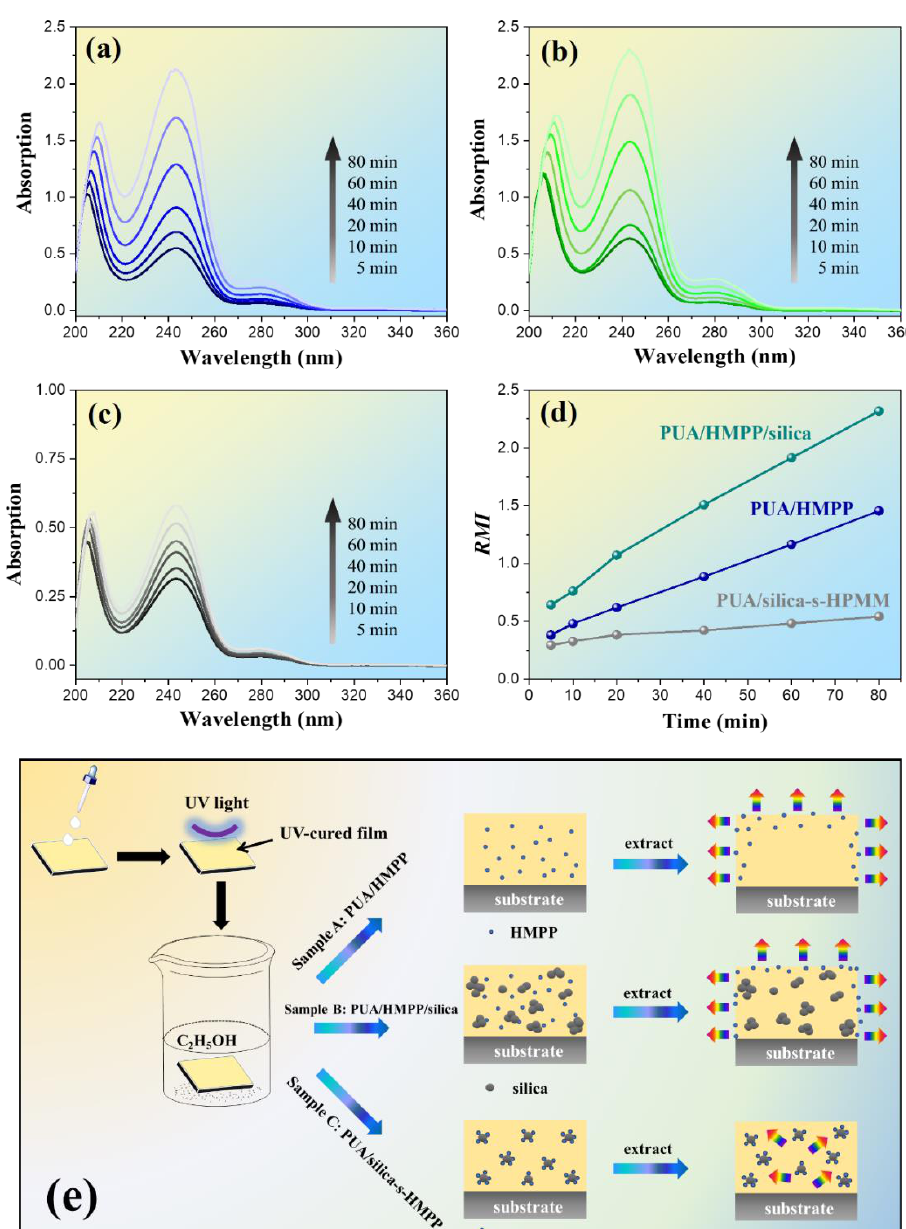
Figure 5. UV-vis absorption spectra of extractable content from UV-cured films ( a ) PUA/HMPP, ( b ) PUA/HMPP/silica, ( c ) PUA/silica-s-HMPP, ( d ) relative migration index (RMI) vs. immersion time, and ( e ) test method and mechanism of migration of different photoinitiators in the UV-cured films.